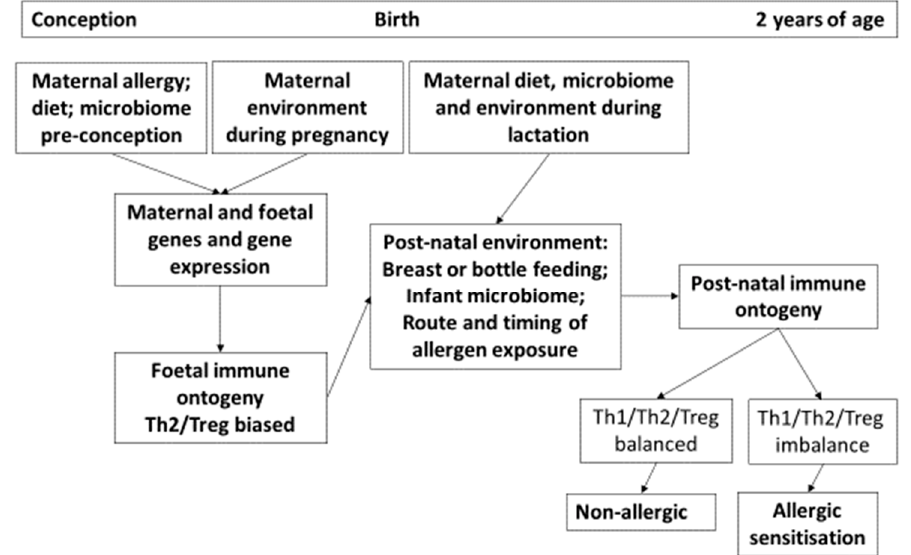
Figure 3. The first 1000 days representing the early life origins of allergic sensitisation. Ante-natal factors include maternal genome, epigenome, metagenome, diet and environment. In the post-natal period, the evolving infant microbiome, diet, route and timing of allergen exposure are critical to balancing the otherwise Th-2 allergy biased neonatal immune response. Failure to down-regulate the neonatal Th-2 biased response is associated with a higher risk of allergic sensitization. The arrows indicate the direction of effect